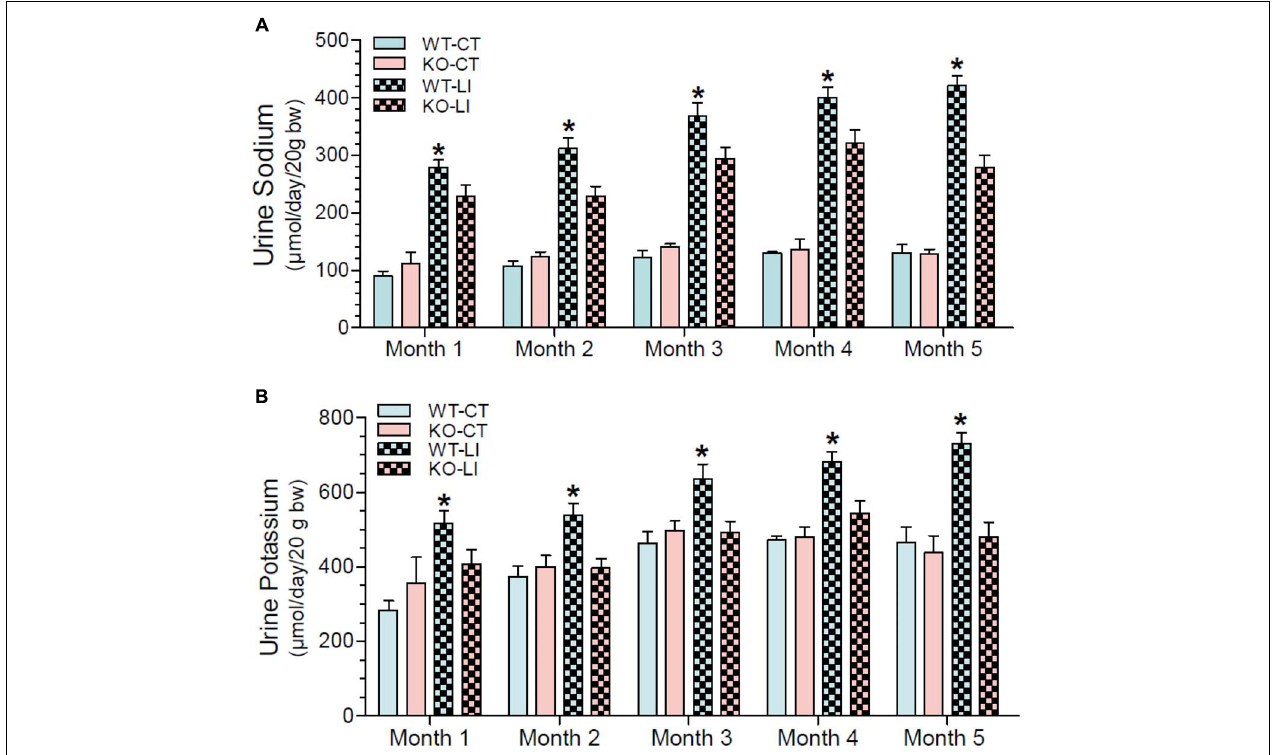
FIGURE 6 | Monthly record of water intake urine sodium (A) and potassium (B) in WT and P2Y 2 KO mice fed control or lithium-added diet for 5 months. Values shown are mean ± se of 24-h samples (CT, n = 5 mice/genotype; LI, n = 10 mice/genotype). ∗ Significantly different from the corresponding WT-CT and KO-LI at all time points by one-way ANOVA.